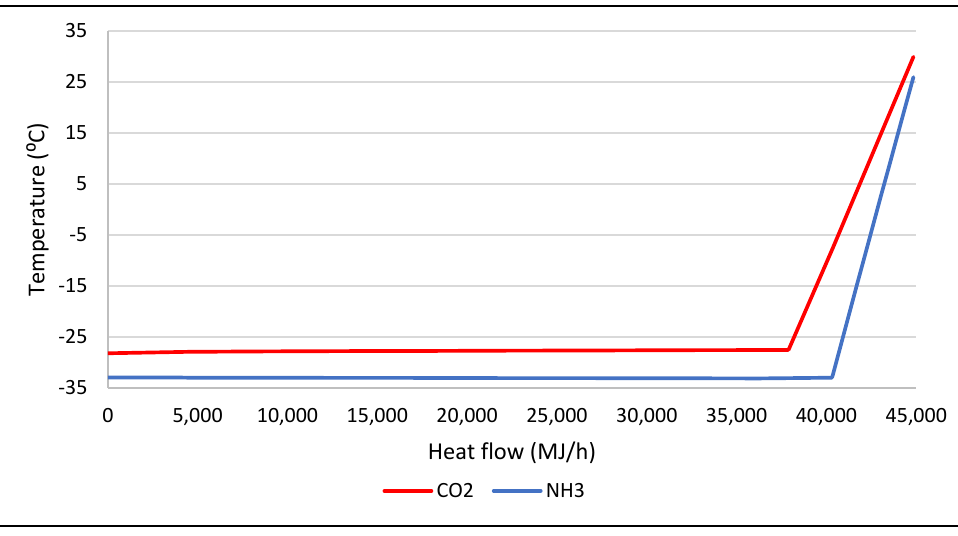
Figure 12. Heat curve for the heat exchanger. Hot composite/CO 2 stream (red) and cold composite/NH 3 (blue). Table 7. Results for the closed-cycle configuration 1.